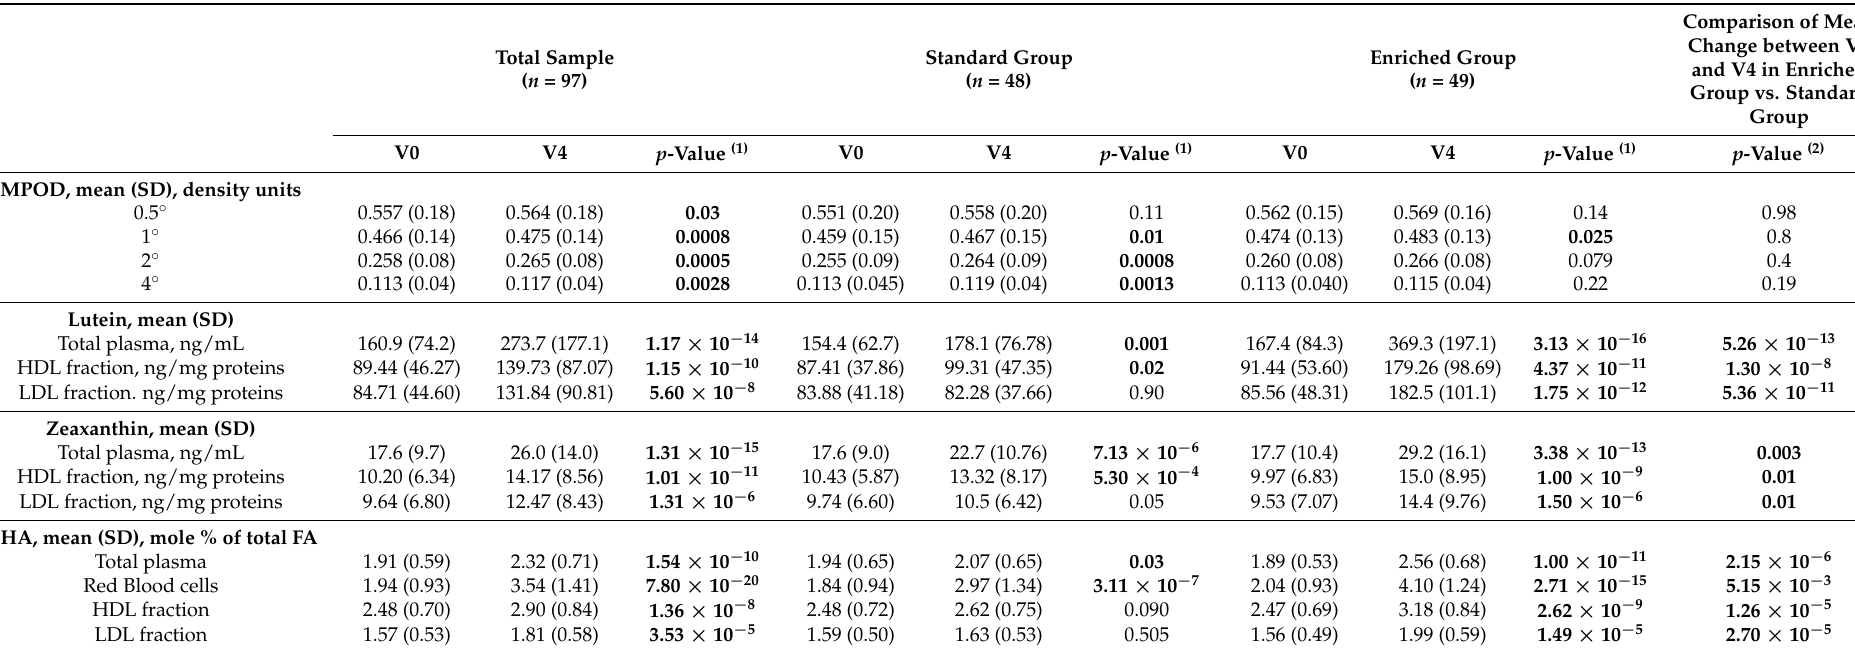
Table 4. MPOD and plasmatic xanthophyll and DHA concentrations in participants before and after daily consumption of two standard or lutein-zeaxanthin-DHA-enriched eggs for 4